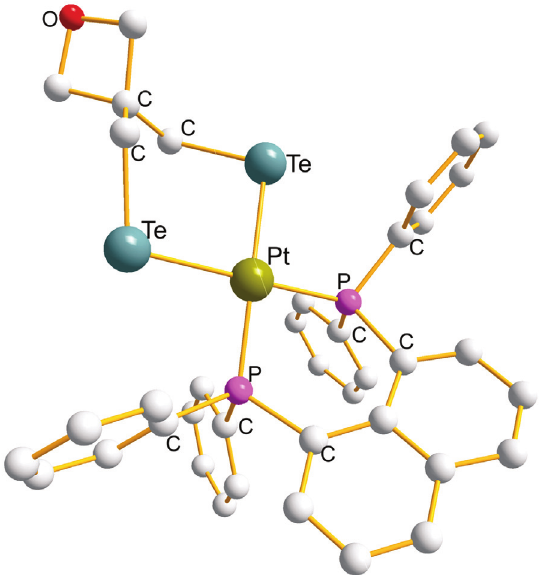
Figure 4: Structure of cis-[Pt{η 2 -Ph (Wagner et al.,